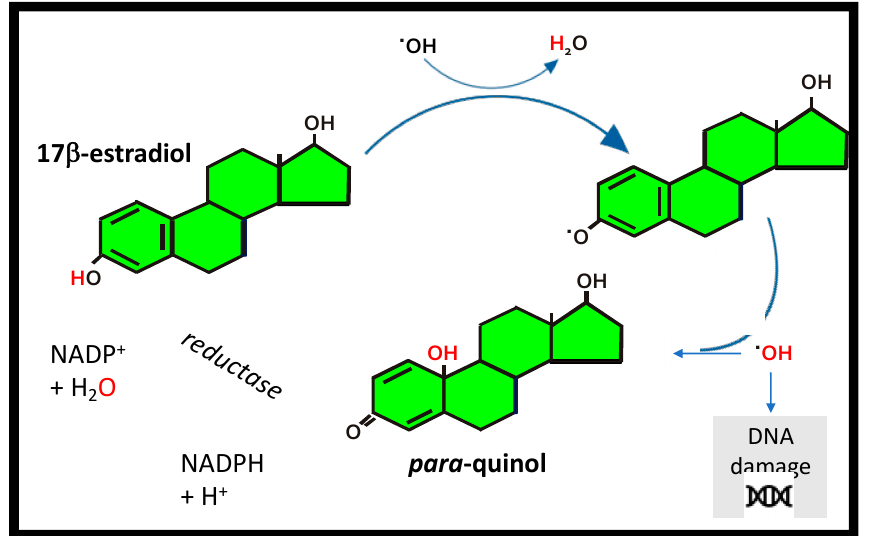
Figure 4. 17 β -estradiol as an antioxidant. The antioxidant cycle for 17 β -estradiol by transfer of a H-atom to a free radical ( • OH), to form a phenoxyl radical that scavenges • OH forming a para-quinol which undergoes enzymatic reduction in the presence of the cofactor nicotinamide adenine dinucleotide phosphate (NADPH) to convert back to 17 β